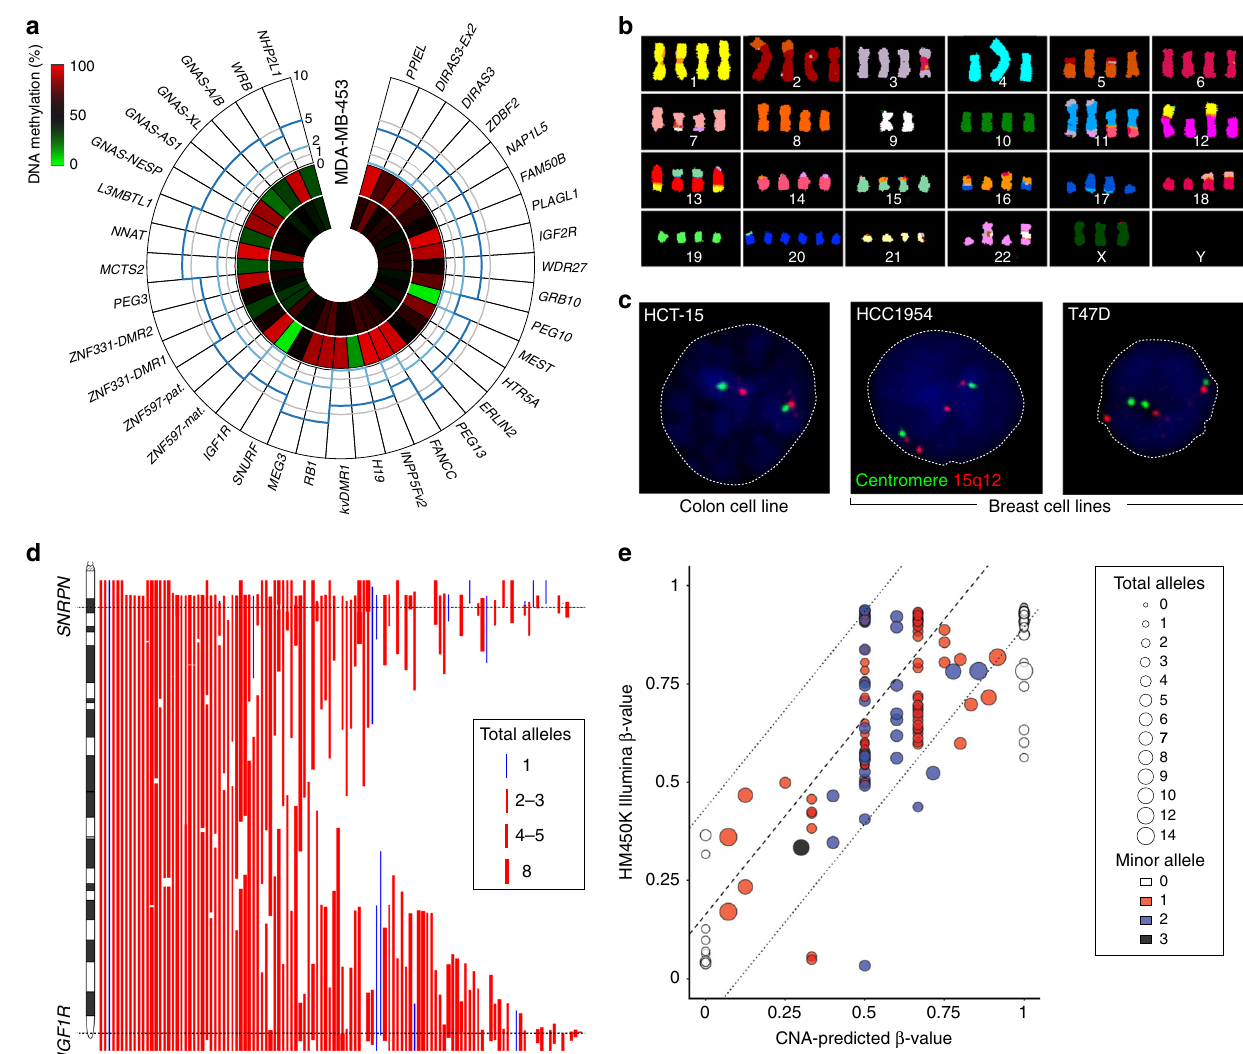
Fig. 1 Analysis of copy-number and methylation of imprinted regions in cancer cell lines. a A Circos graph showing the average methylation for probes mapping within each imprinted DMR for the breast cancer cell line MDA-MB-453. The center heatmap represents the methylation pro fi le obtained from the Illumina In fi nium HM450k methylation BeadChip array of 19 normal breast samples, whereas the outer heatmap represent the pro fi le of the cell line. The outer section represents the average copy number for each imprinted loci, obtained from Affymetrics SNP6 array data, depicted as minor allele count ( light blue ) and total copy number ( dark blue ). b Sky karyotype validation for the same cell line revealing near tetraploid status. c Standard DNA FISH analysis for the chromosome 15q11-13 region in three cell lines. The red probe maps ~1Mb from SNRPN in the GABRB3 gene, while the green probe maps to the centromere. The colorectal cell line HCT-15 has normal copy-number, whereas the two breast cancer cell lines carry CNAs. The HCC1954 cells have a focal ampli fi cation of SNRPN while the ampli fi cation in the T47D cells incorporates the centromere. d A chromosome ideogram showing the extent of ampli fi cations and deletions for the SNRPN and IGF1R domains on chromosome 15. Ampli fi cations are in red and deletion in blue with the width of the lines representing the total copy-number for each aberration. e The observed vs. expected methylation pro fi le for the PPIEL domain in lung-derived cancer cell lines. The dashed lines represent the ± 3 s.d. of the mean of normal control tissues. Data points outside this range are deemed to have a methylation pro fi le independent of